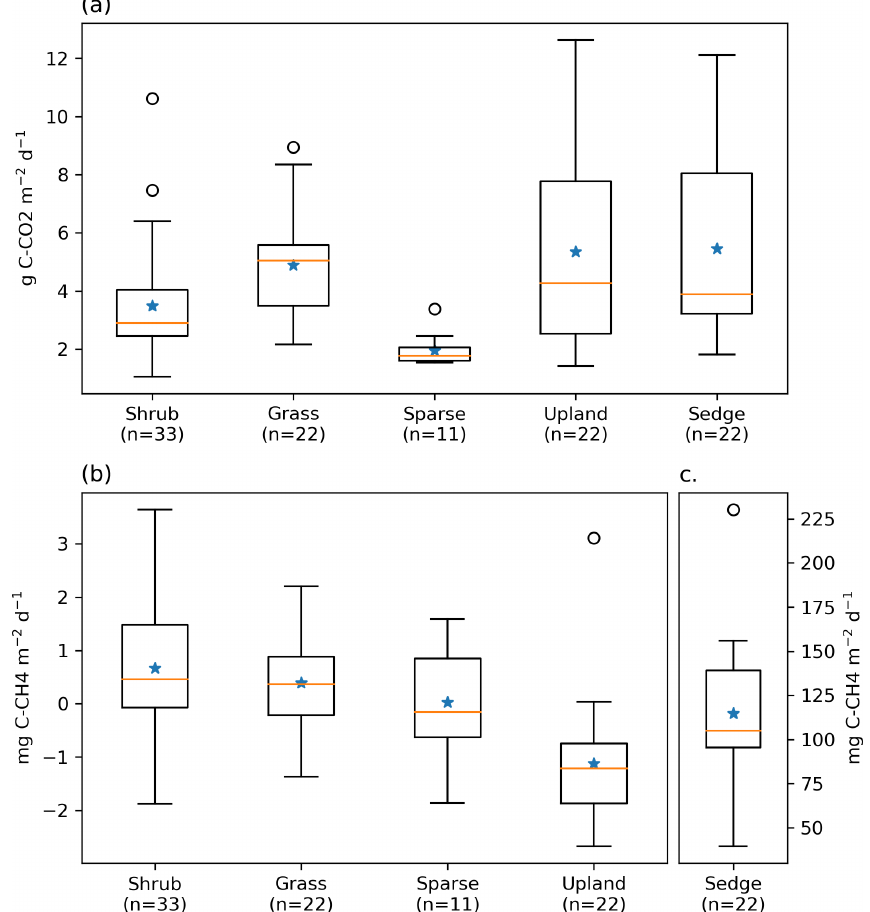
Figure 3. Box plot of (a) ER, (b) NME, and (c) NME fluxes measured using closed chambers, grouped by vegetation class. The orange lines represent the median, blue stars represent means, the boxes indicate the interquartile range ( Q 1 – Q 3 ), the whiskers indicate Q 1 − ( 1 . 5 × IQR ) and Q 3 + ( 1 . 5 × IQR), and the circles represent outliers extending beyond the whiskers. Note the scale for (c) sedge is